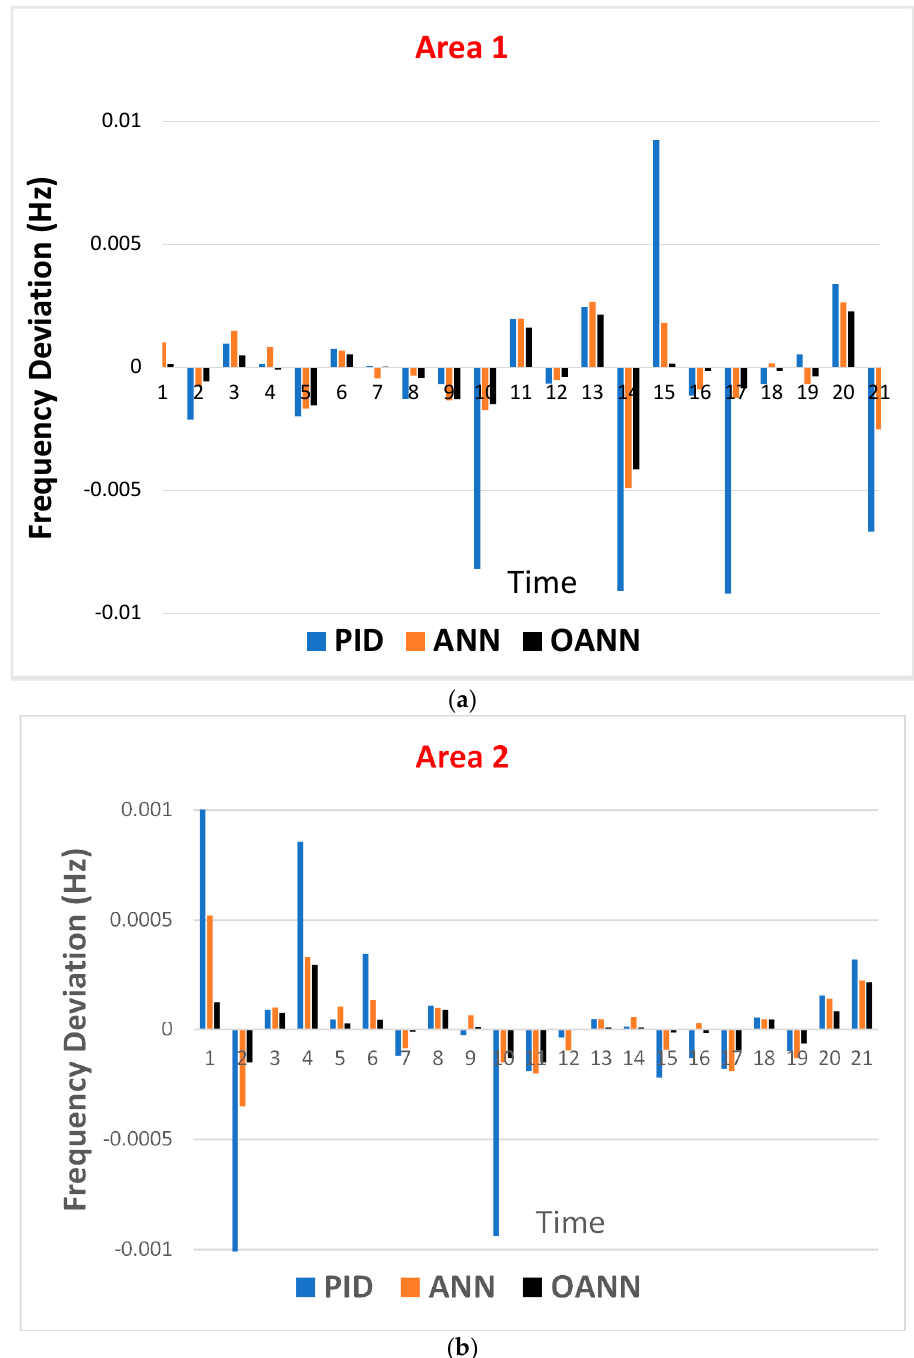
Figure 18. The active power mismatches between the supplied power and demanded power in Area 2.